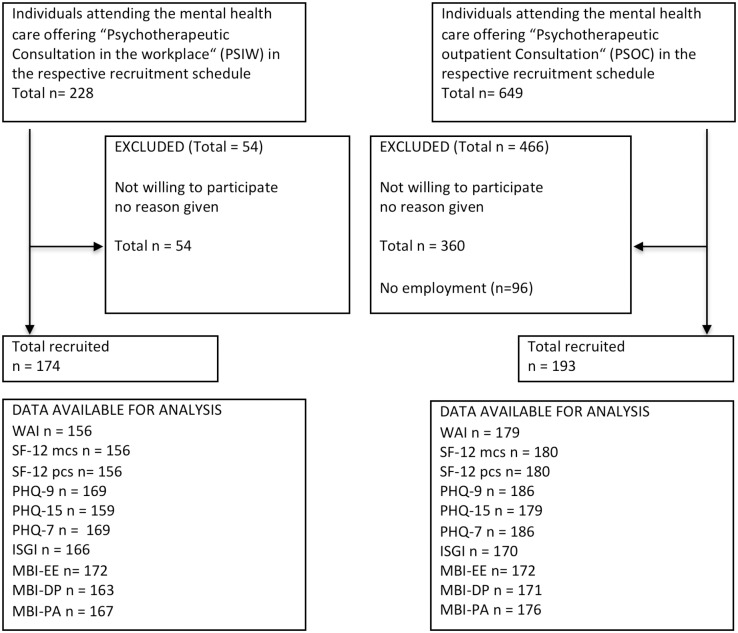
Flowchart participants according to the STROBE criteria [34].